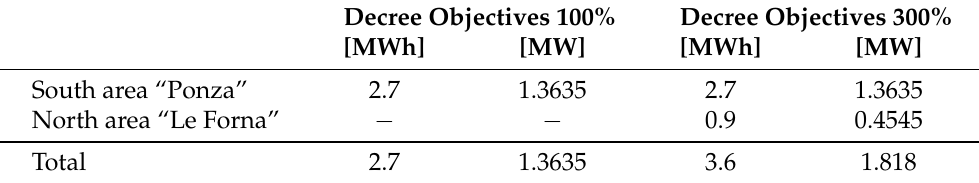
Table 10. BESSs deemed necessary to meet the objectives of the